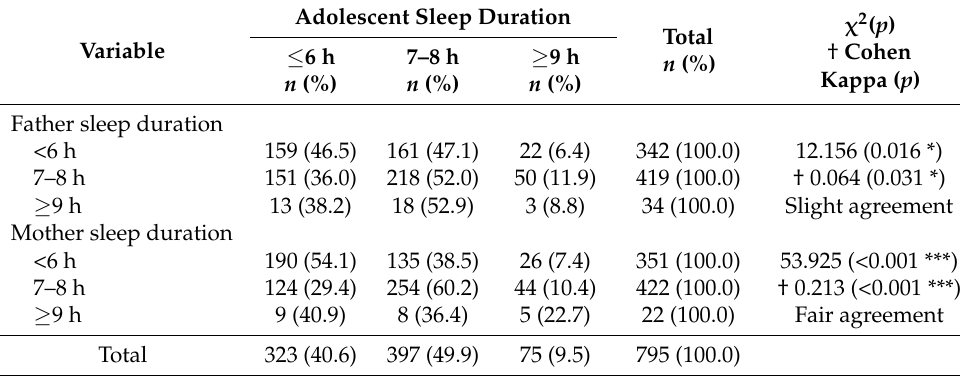
Table 4. Kappa statistics of the adolescents’ and parents’ sleep